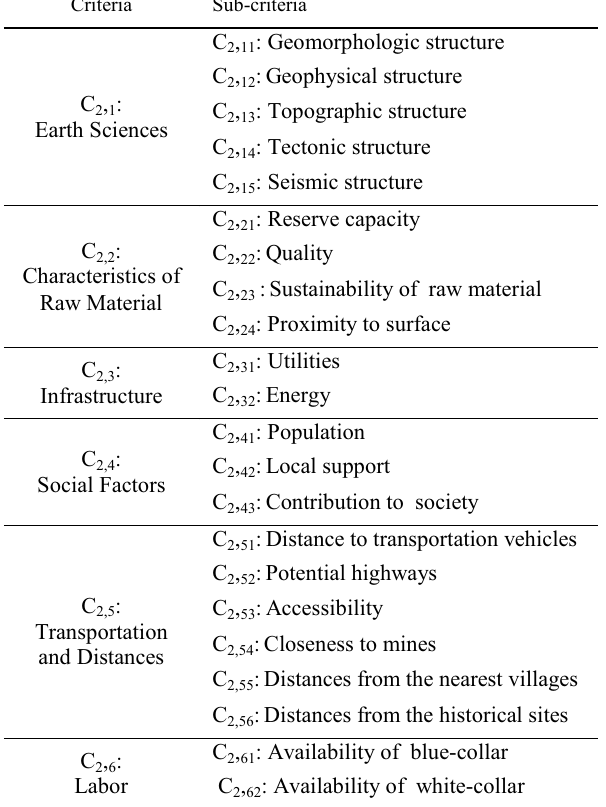
Table 5. Criteria and sub-criteria for Stage 2 Criteria